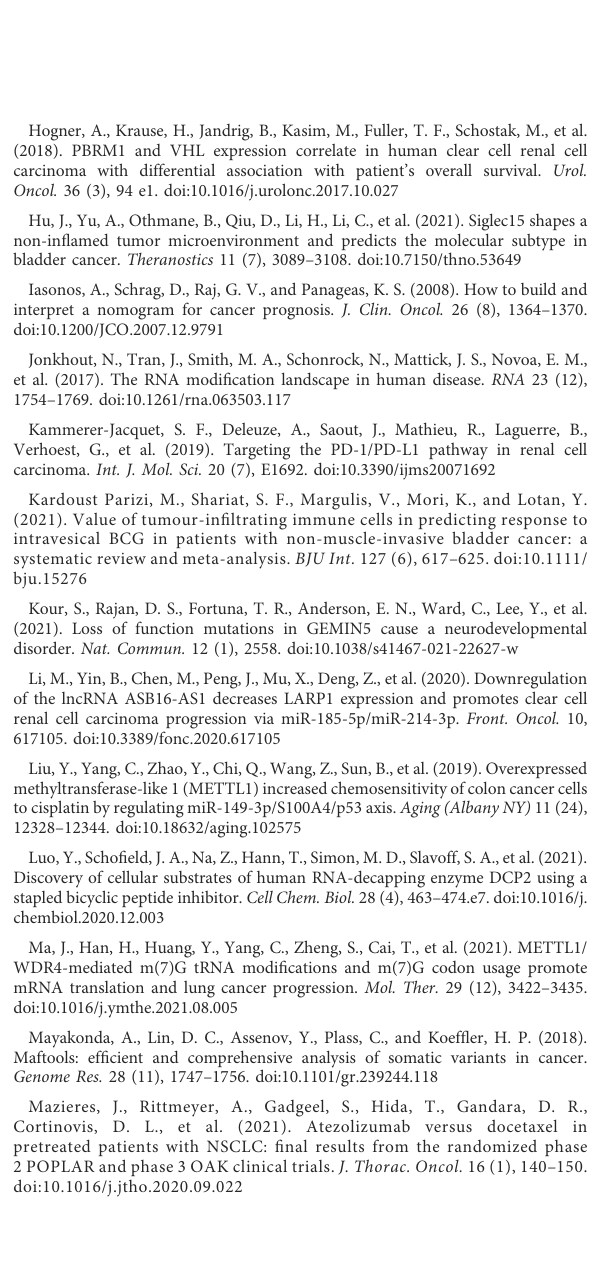
SUPPLEMENTARY FIGURE S2 Lasso regression of the prognostic model.